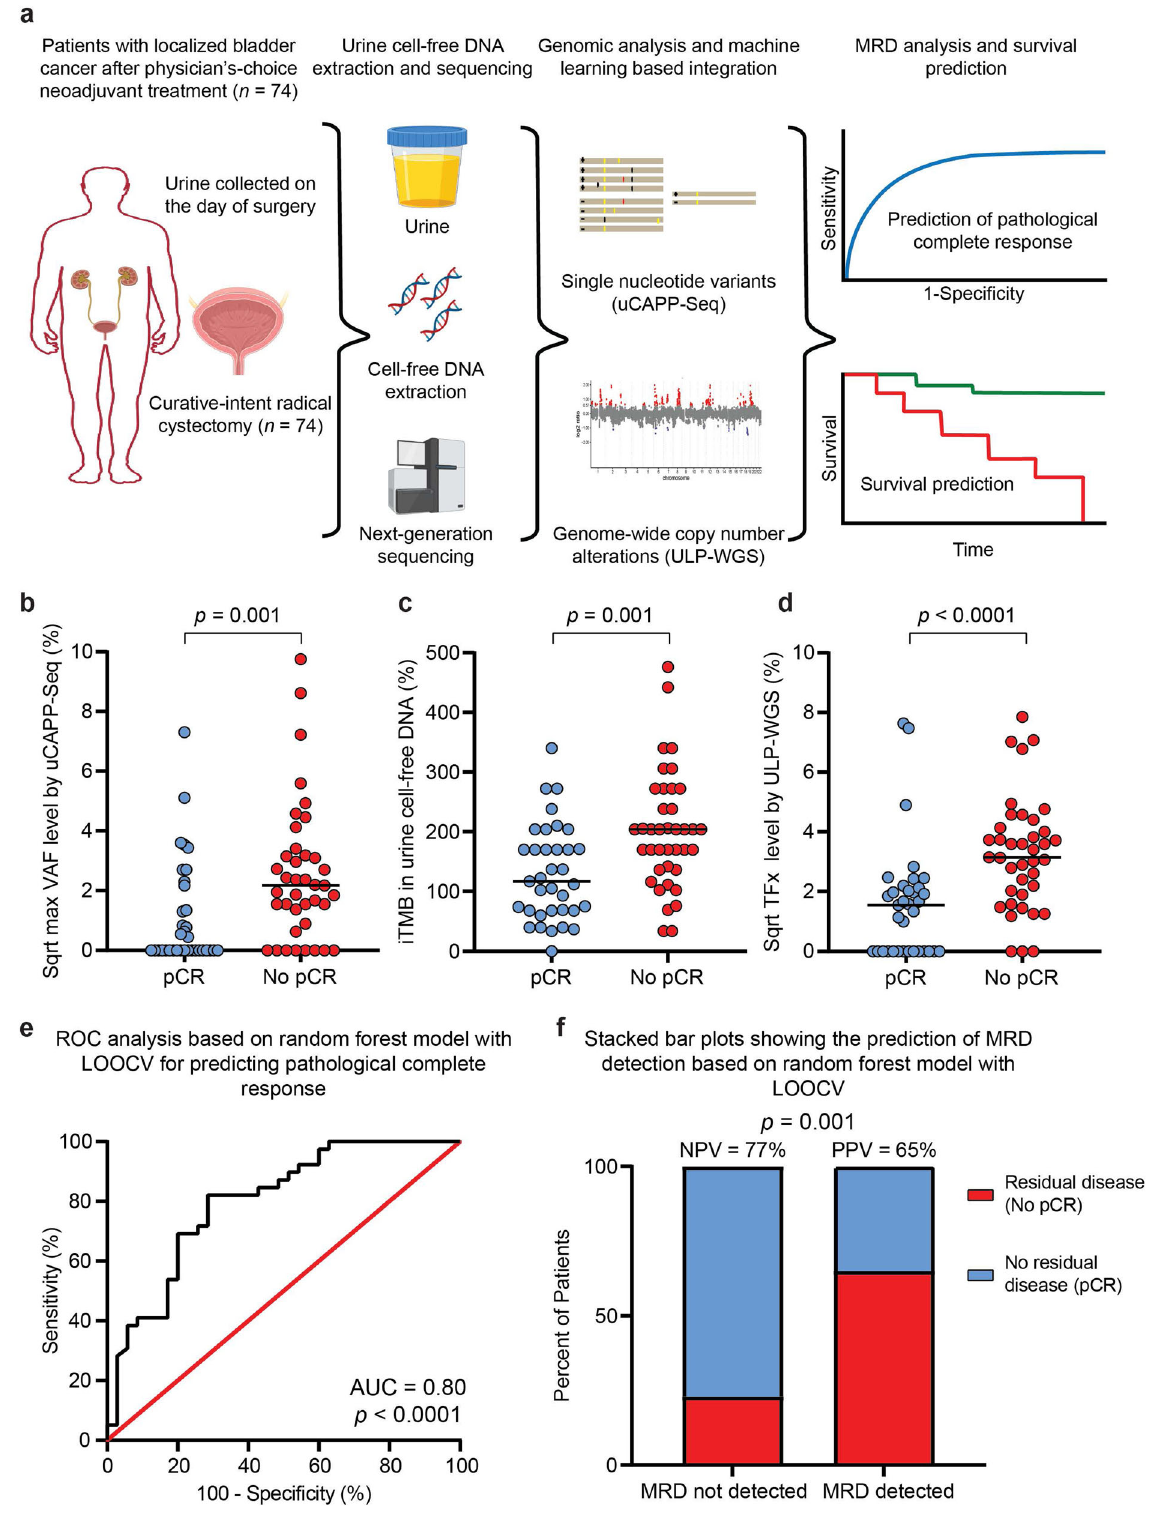
DNA (Supplementary Fig. 4). We also measured the tumor mutational burden inferred from the number of non-silent mutations detected in urine cfDNA (iTMB). The median iTMB was 170 (range 0 – 476) across the cohort, consistent with previous reports in bladder cancer 7 . Comparing between